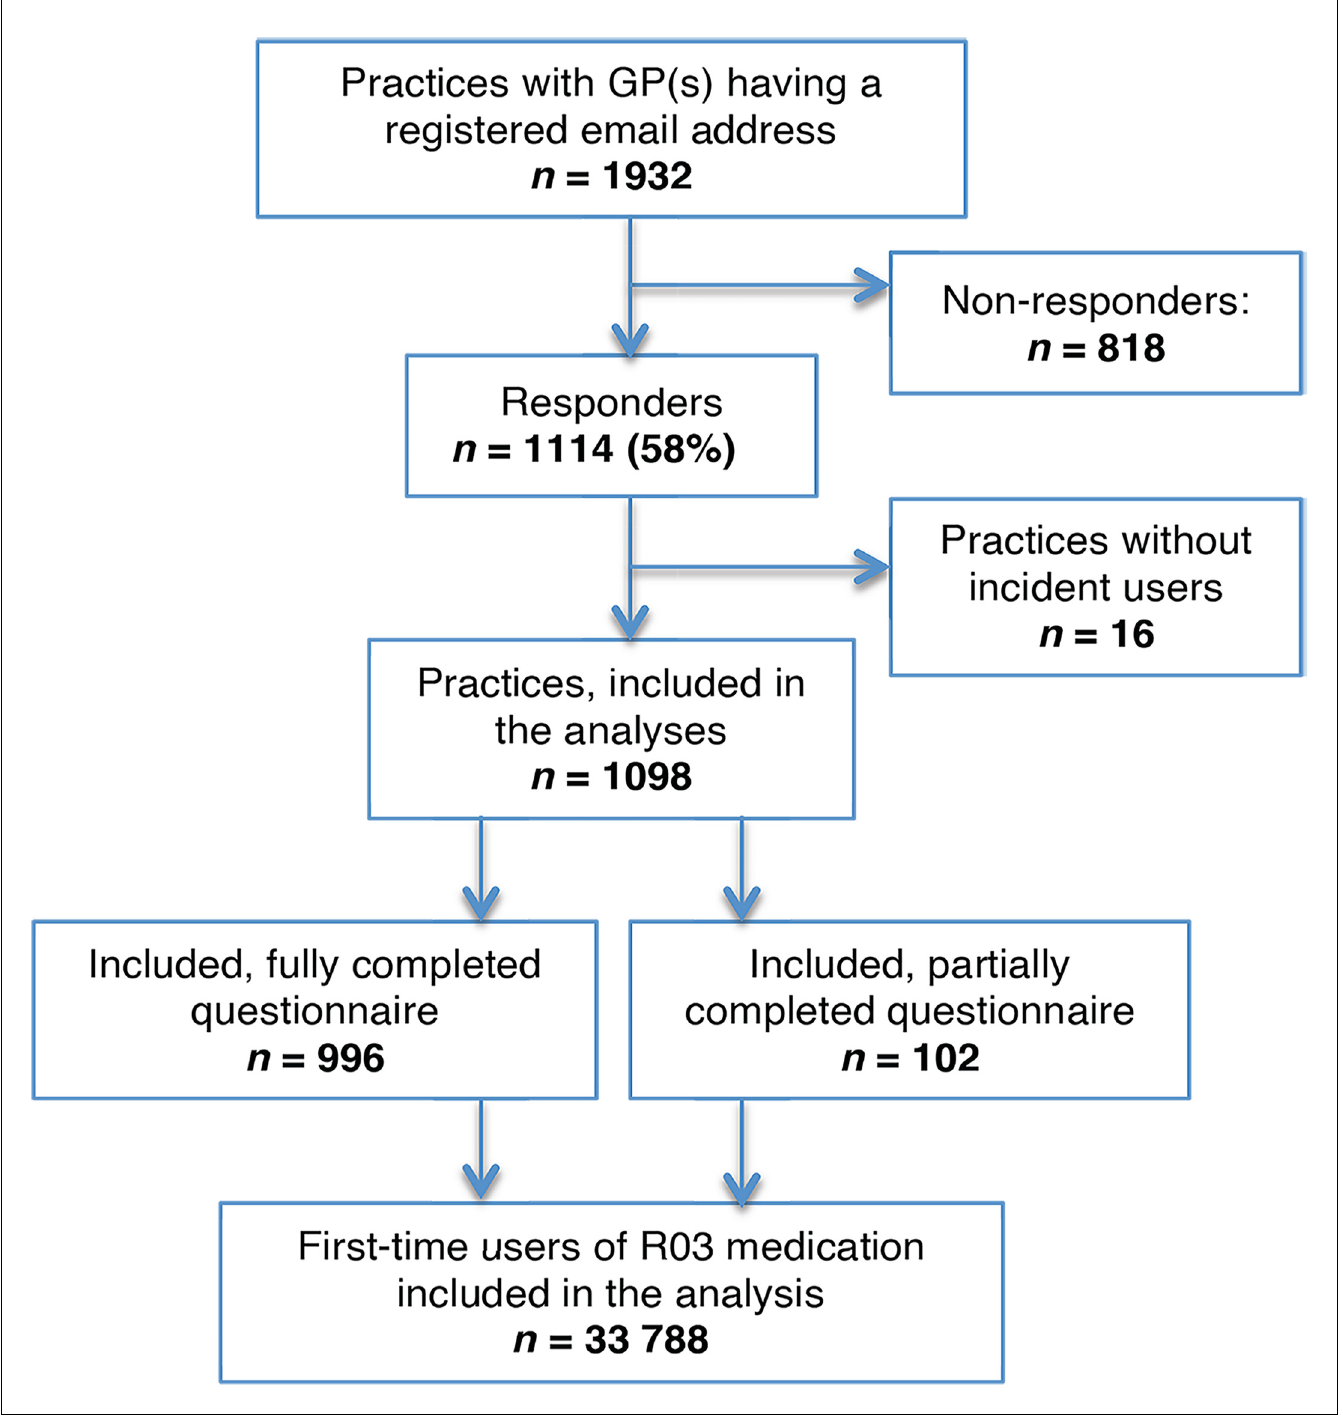
Figure 1. Flowchart of the study